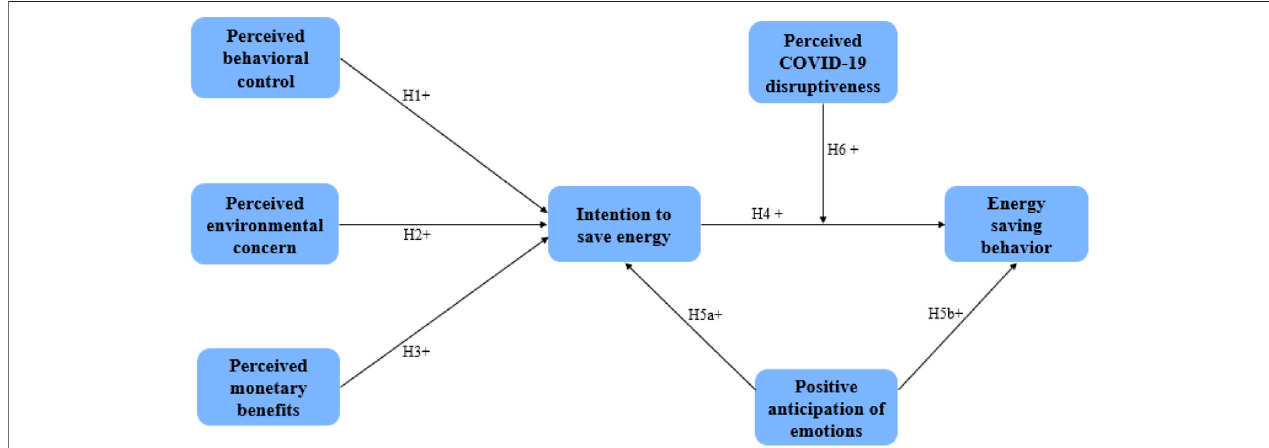
FIGURE 1 | Conceptual framework.